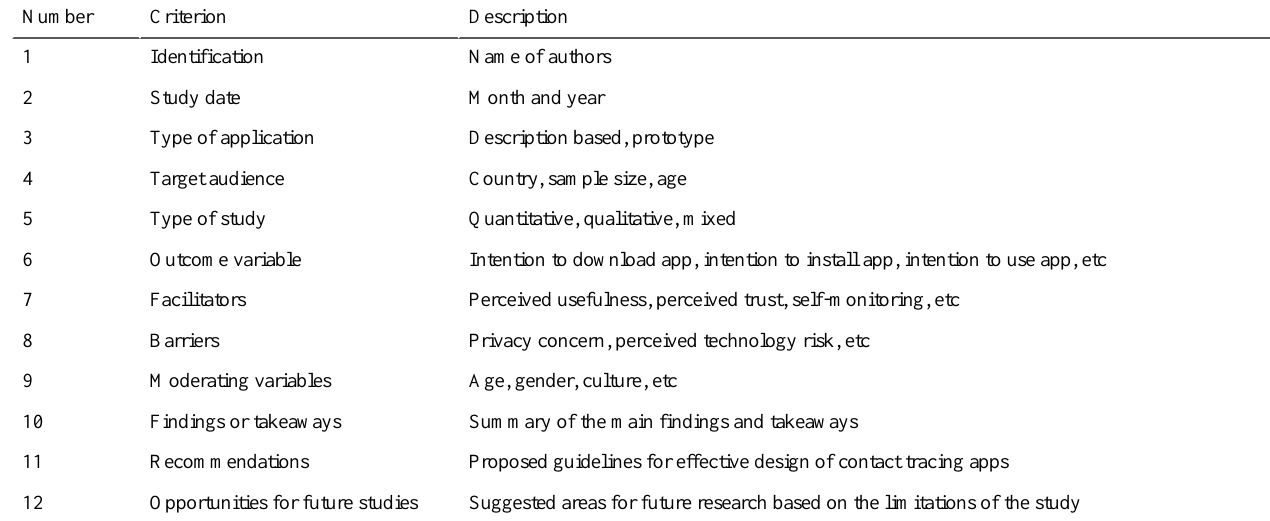
Table 1. Systematic analysis coding